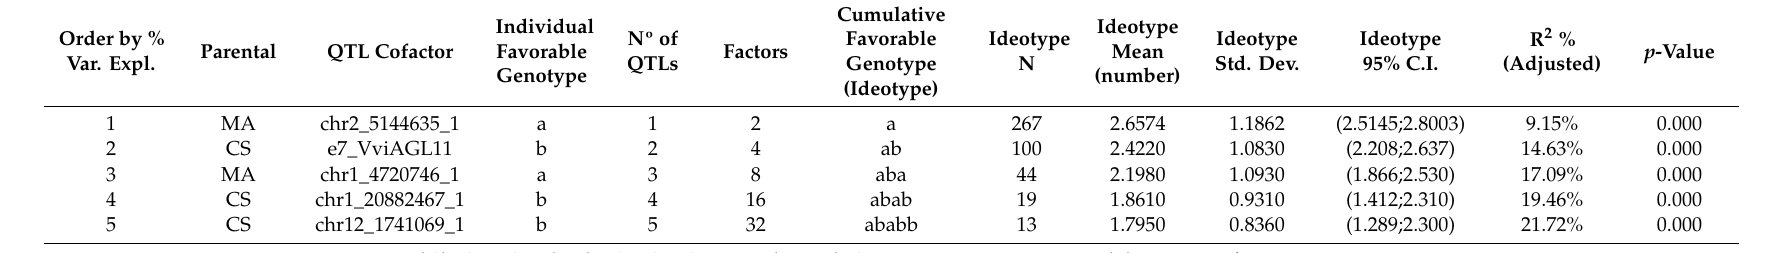
Multiloci Assisted Selection in Bi-Parental Population, One-Way ANOVA Model Summary for SEDA, n = 569 Order by % Var.